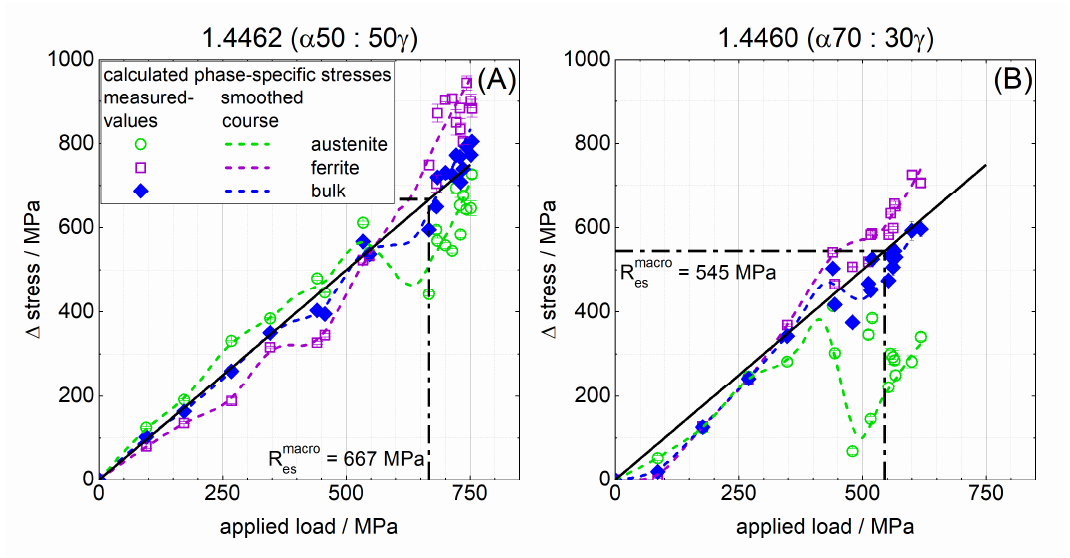
Figure 11. Phase-specific stress vs. load stress in the relaxed state after unloading for both stainless duplex steels. ( A ) Duplex stainless steel 1.4460; ( B ) duplex stainless steel 1.4462. In ( A ), a phase content of α 70:30 γ was assumed, and in ( B ), α 50:50 γ was assumed. The macro stress in blue was calculated via the nominal volume content. The black line represents the direct relationship between the applied load stress and the calculated stress. The dashed line corresponds to a smoothed curve of the phase-specific